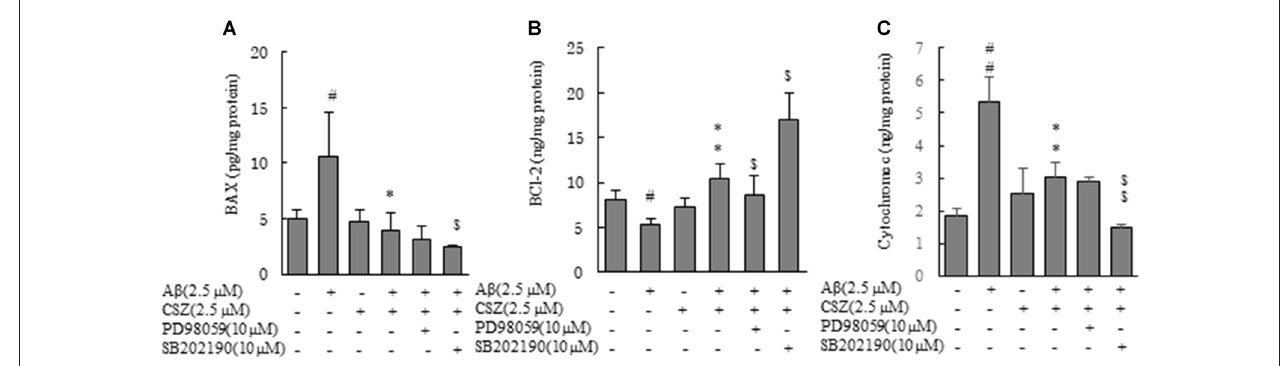
FIGURE 6 | Effects of CSZ and inhibitors of MEK1/2 and p38 MAPK on Bax, Bcl-2 and cytochrome c in A β - timulated SH-SY5Y cells. Levels of Bax and Bcl-2 were determined in SH-SY5Y cells incubated with or without 1 h pretreatment with CSZ or inhibitor of MEK1/2 or p38 MAPK followed by 20 h incubation with A β . Cells were extracted with a cell lysis buffer and quantitative determination of Bax, Bcl-2 and cytochrome c. (A) Bax (B) Bcl-2 (C) cytochrome c. Values are expressed as mean + SEM # Compared vs. control cells ( p < 0.05). ## Compared vs. control cells ( p < 0.01). ∗ Compared vs. A β -treated cells ( p < 0.05). ∗∗ Compared vs. A β -treated cells ( p < 0.01). $ Compared vs. A β + CSZ-treated cells ( p < 0.05). $$ Compared vs. A β + CSZ-treated cells ( p < 0.01).